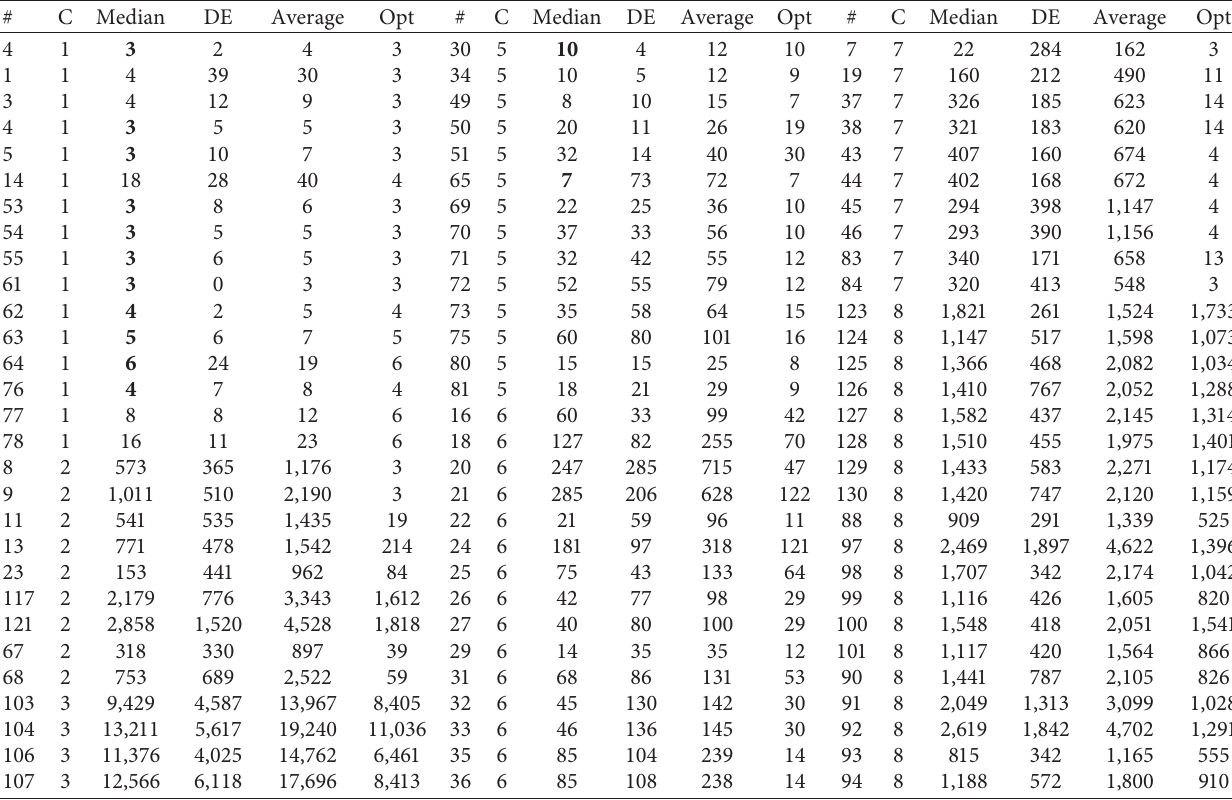
Table 16: Hyperheuristics results for graph coloring and